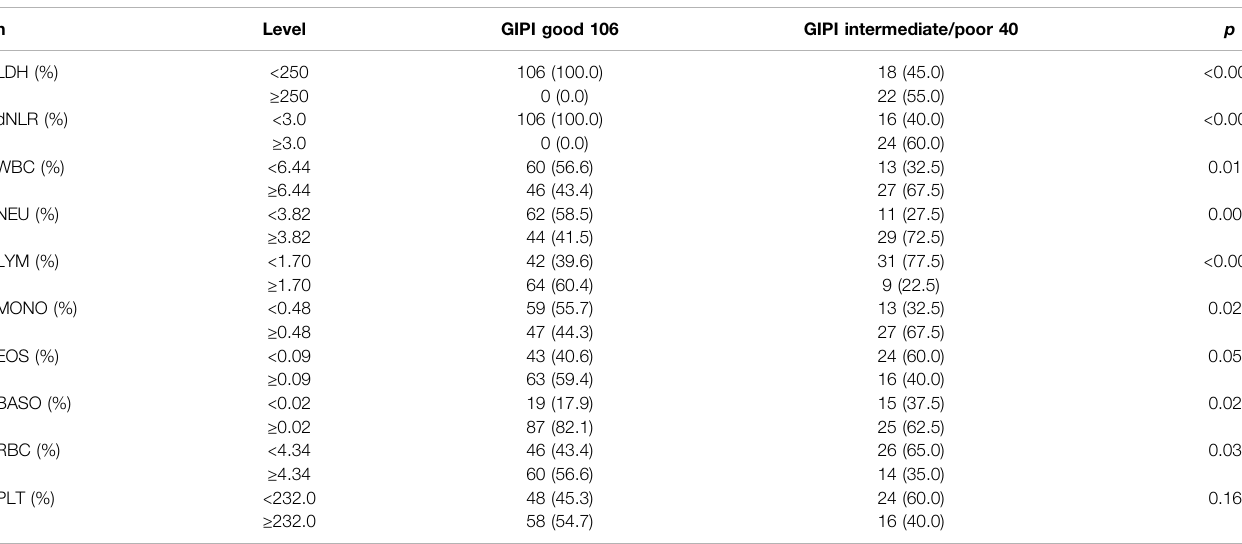
TABLE 2 | The blood parameters of all enrolled